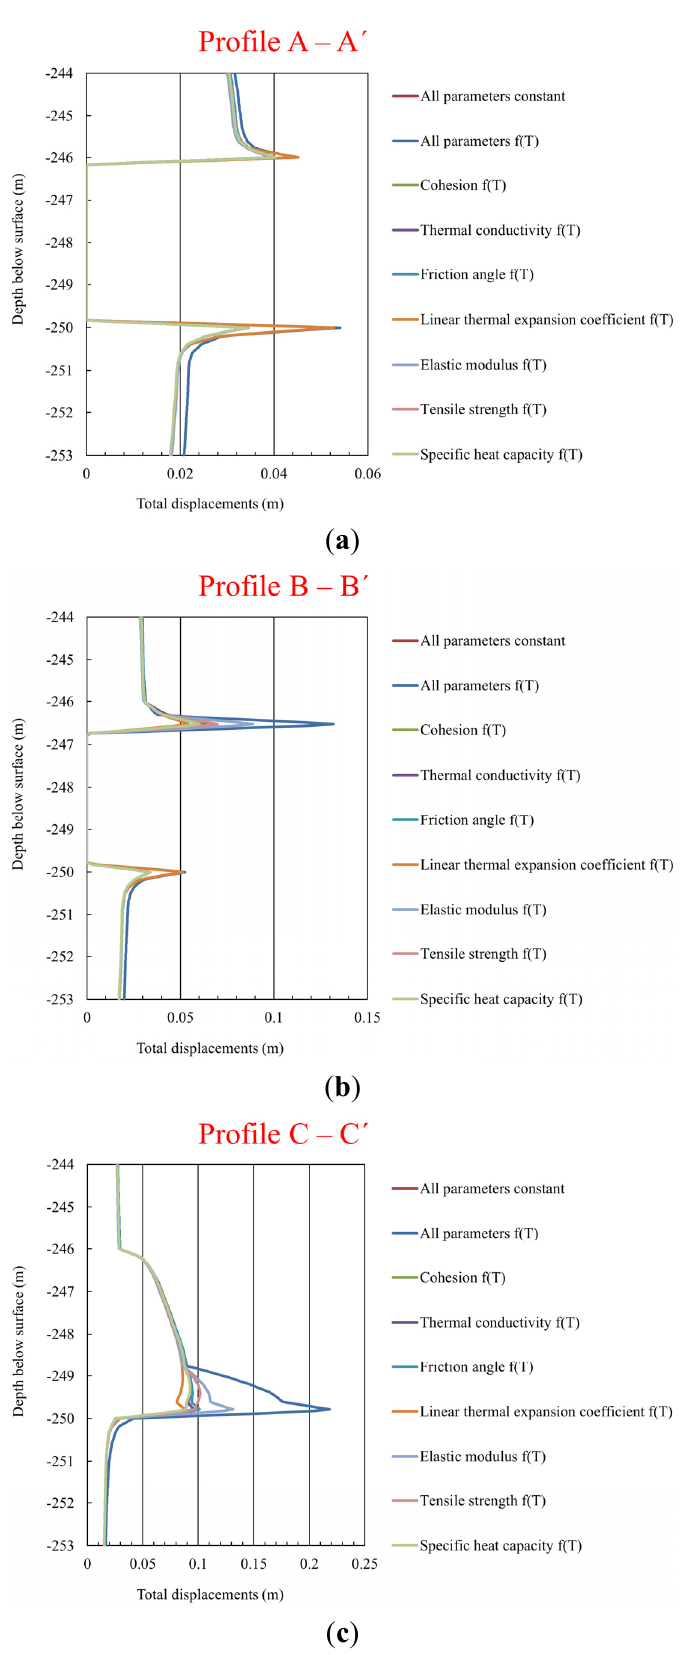
Figure 5. Profiles of total displacements ( a – c ) after one day of simulation show that the thermo-mechanical rock behavior is mainly influenced by the linear thermal expansion coefficient ( α ), tensile strength ( σ t ) and elastic modulus ( E